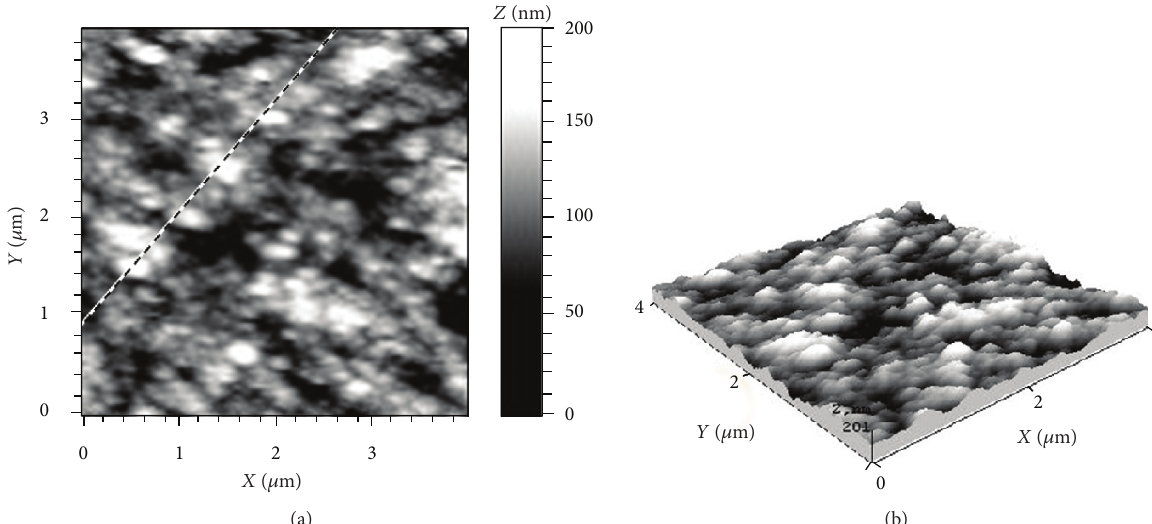
F 2: AFM image of Ag S layer on etched PP surface immersed for 1 time in AgNO 2